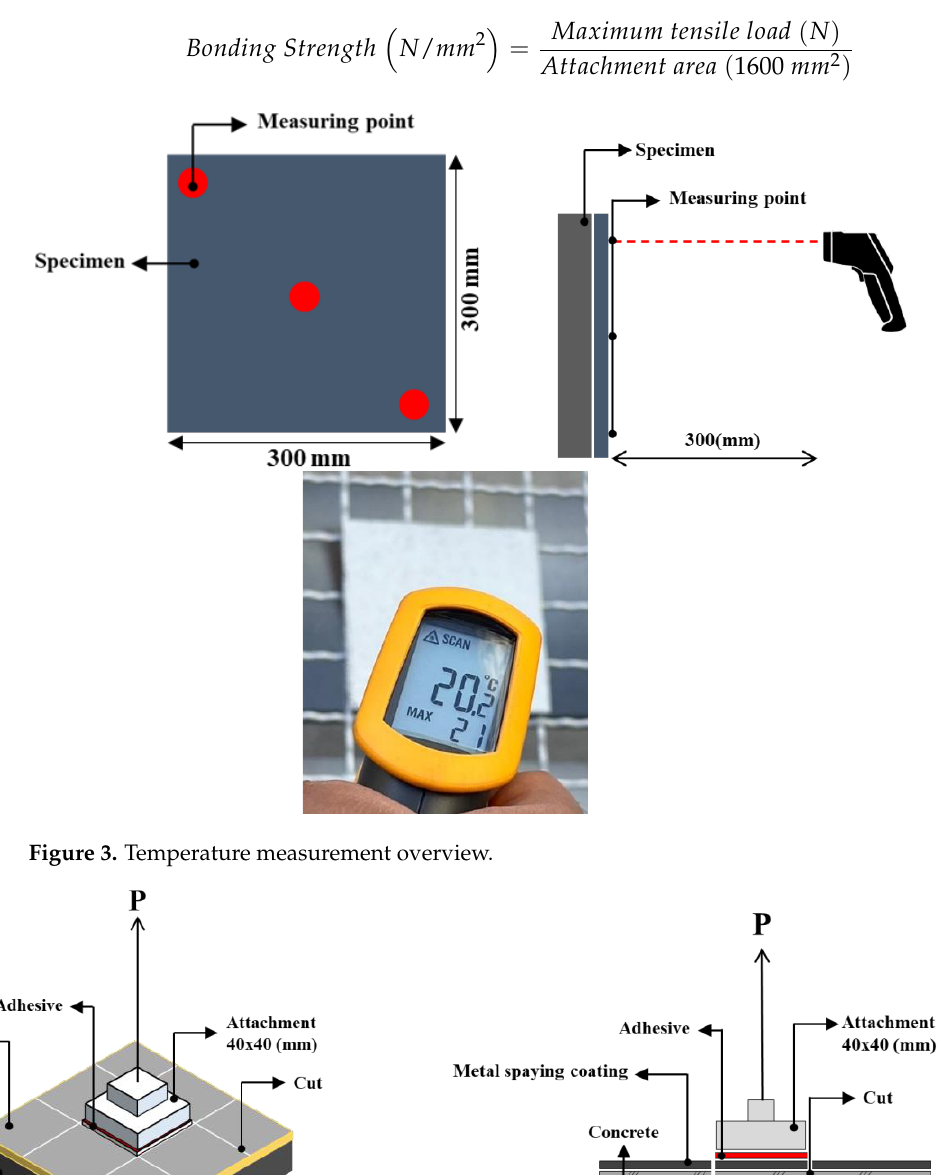
Figure 4. Schematic of the bonding strength measurement. ( a ) Top view; ( b ) Side view.